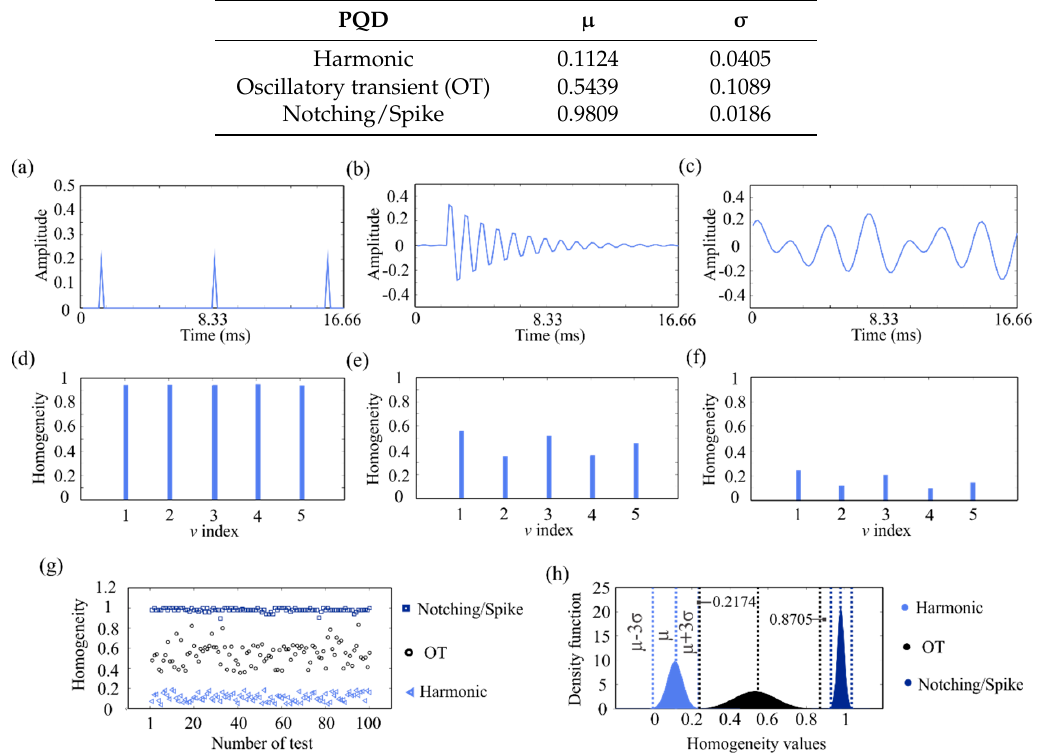
Table 1. H values for PQDs.